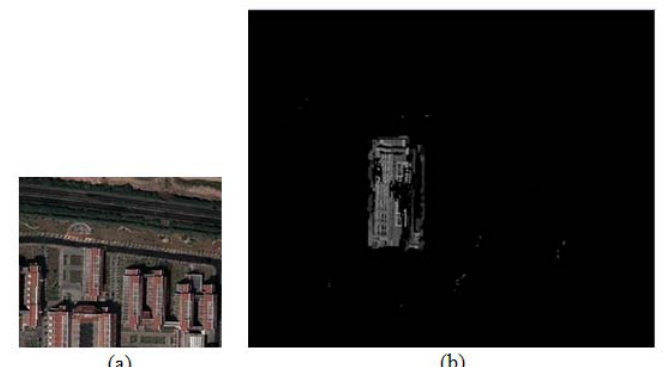
Fig. 9. (a) 2×2 sub-sampling of the sensed image, (b) Reference map of the changed